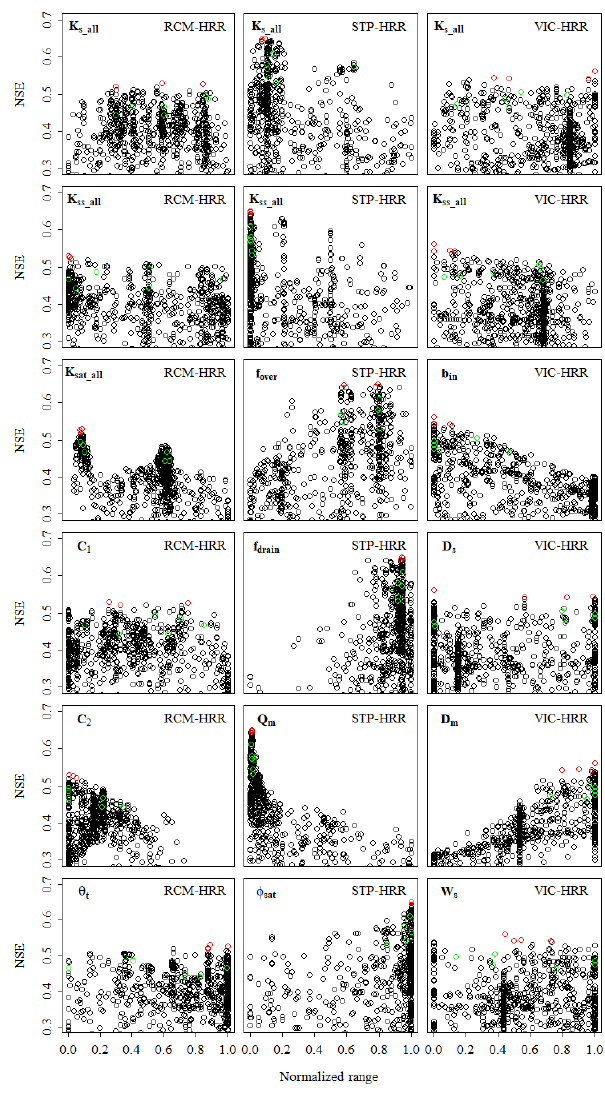
Figure 5. Parameters (black circles) sampled during the calibration process and their corresponding performance (assessed by NSE). The red circles indicate the four parameter sets with the highest NSE values, and the green circles indicate six randomly selected parameter sets from the top 20% samples (ranked by NSE). These 10 parameter sets were used for uncertainty analysis. In this figure, the parameter values are normalized by their ranges (shown in Ta- ble 1), so the range of the x axis is 0–1. The parameters were sam- pled throughout their whole ranges; however, for clarity, samples with NSE lower than 0.3 are not shown in this